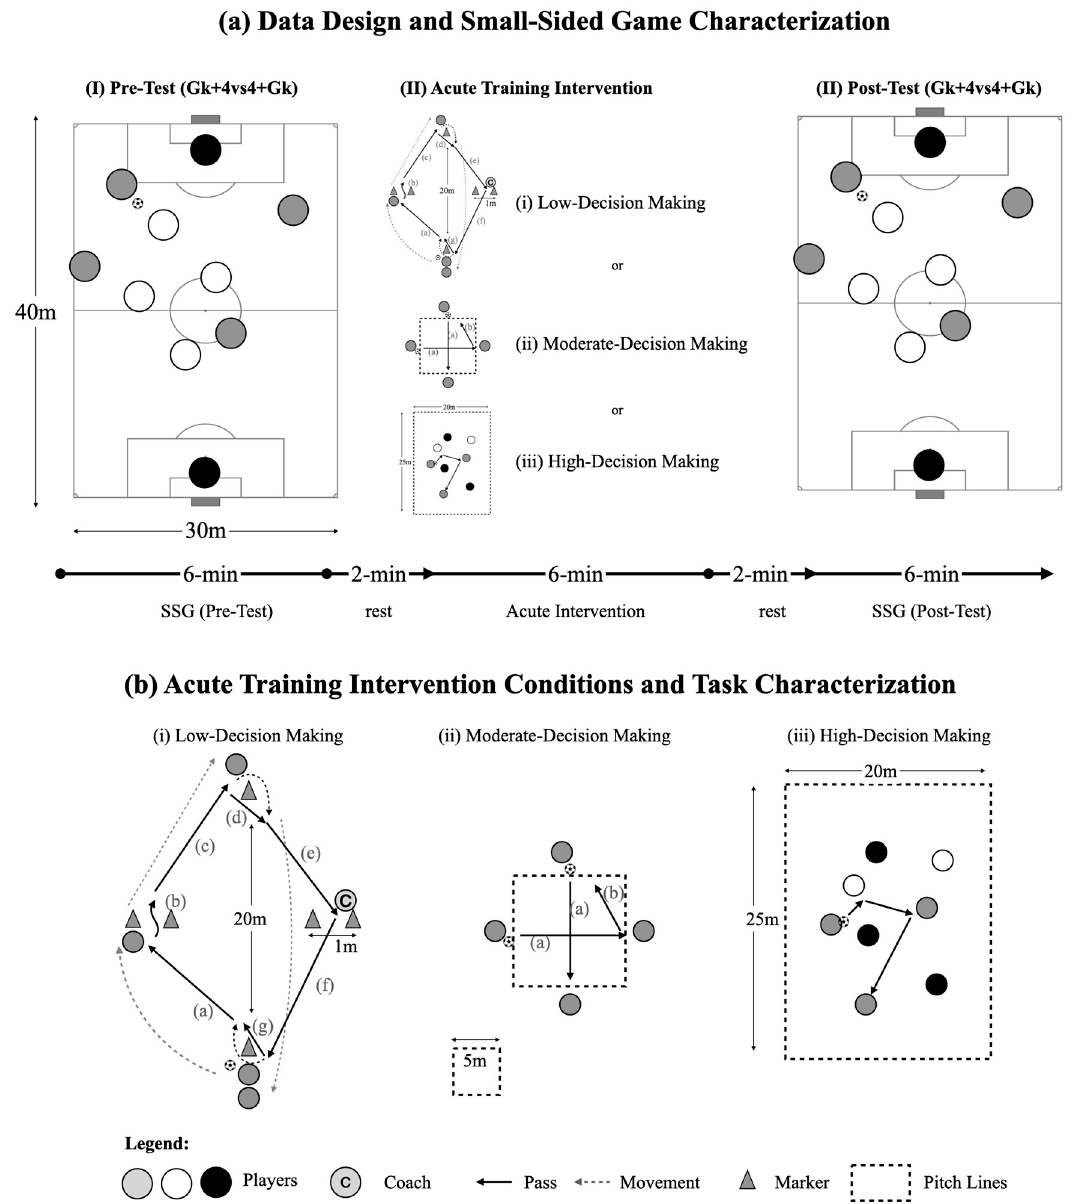
Figure 1. Representation of data design and acute training